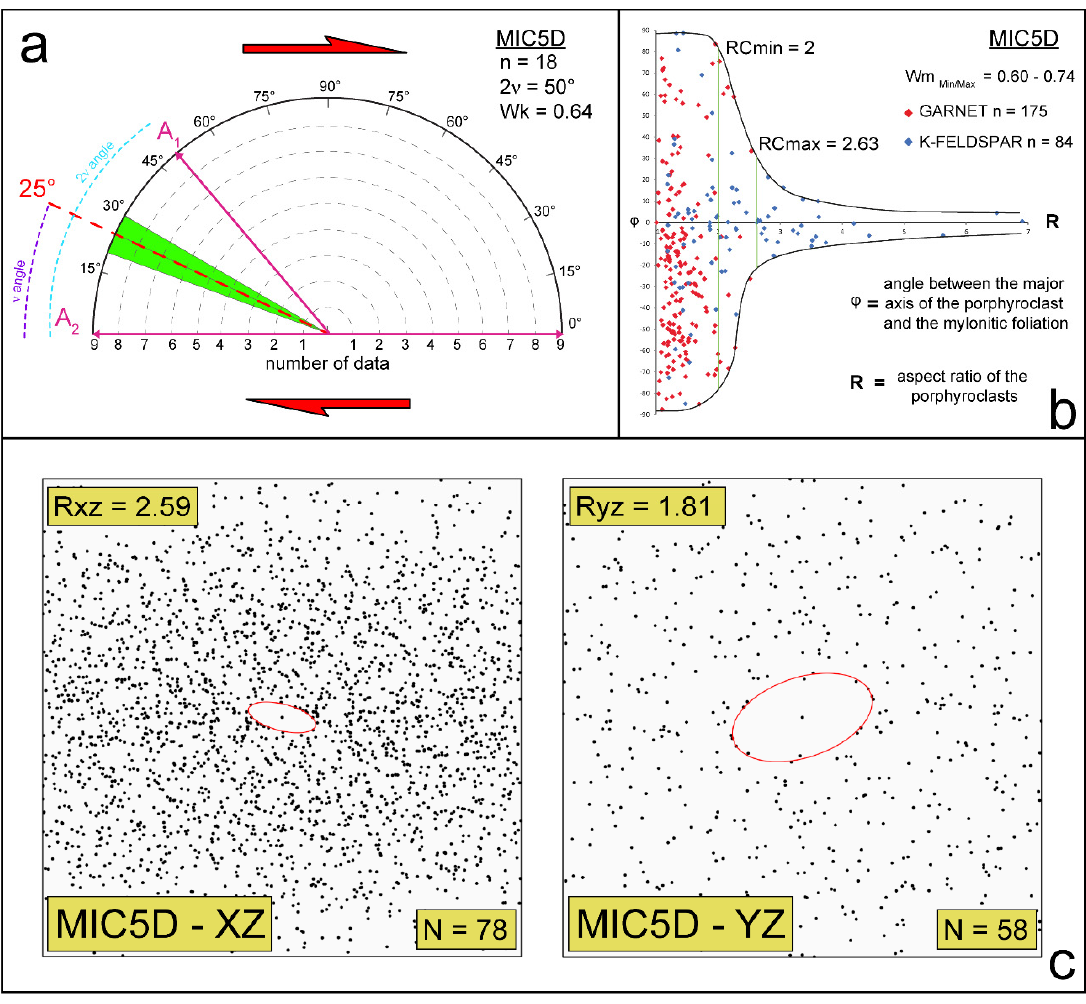
Figure 6. Example of vorticity and finite strain results in a garnet-bearing micaschist: ( a ) polar histogram used to derive the angle ν , between the C’ and C planes, and the corresponding kinematic vorticity number, Wk. A1 = flow apophysis 1; A2 = flow apophysis 2; n = total number of data; ( b ) example of the plot compiled to determine the minimum (Rcmin) and maximum critical